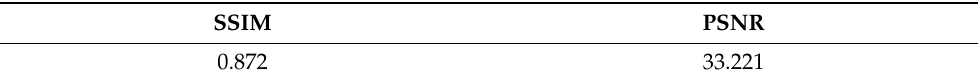
Table 5. Average of Structural Similarity Index (SSIM) and peak signal-to-noise ratio (PSNR) for 100 random